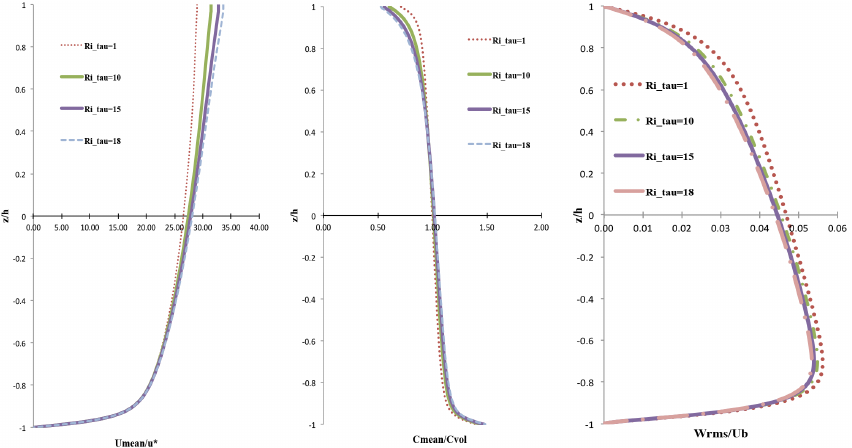
Figure 7. Results from the DNS simulations in a boundary-layer (open-channel-like) setting, for increasing Ri τ and ˜ V = 0 . 025. Mean streamwise velocity of the flow increases with increase in Ri τ . An increase in Ri τ increases the degree of self-stratification of the flow; this leads to an increase in the sediment concentration gradient and higher amount of turbulence damping through out the domain. Normalized turbulence intensity ( W rms /U b ) is damped throughout the boundary layer but the level of suppression is slightly higher in the upper